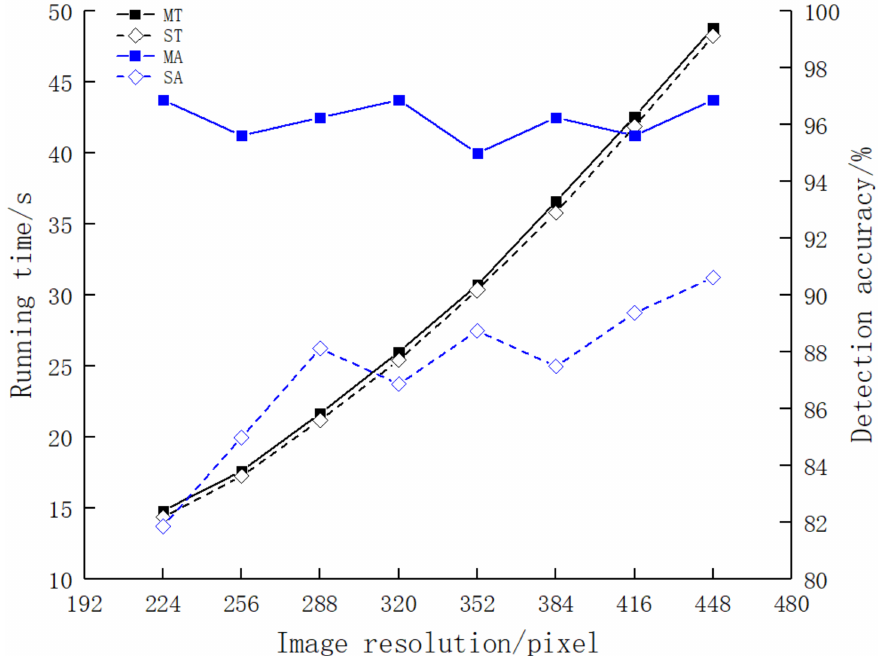
Figure 9. The relationship between model running time, detection accuracy, and image size. MT denotes running time when using the matrix splicing scheme; ST denotes running time when using the sequential splicing scheme; MA denotes detection accuracy when using the matrix splicing scheme; SA denotes detection accuracy when using the sequential splicing